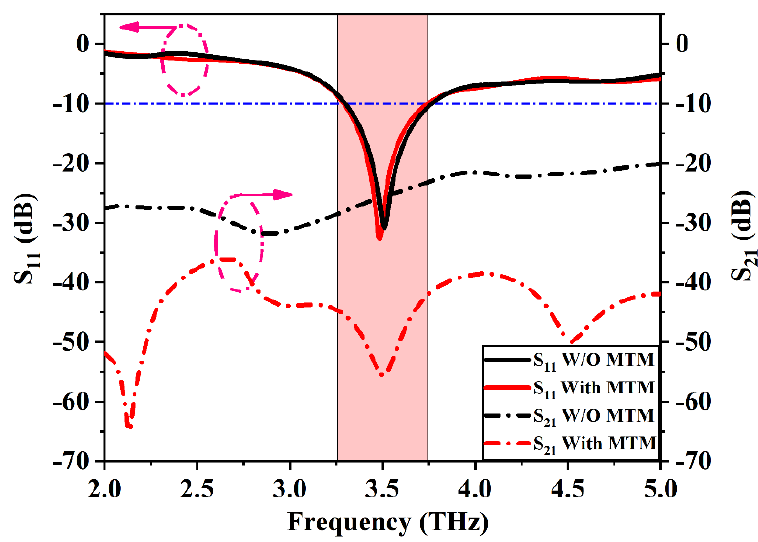
Figure 18. S − Parameters (S 11 and S 21 ) of Ant. C with and without the MTM unit cell . Figure 18. S–Parameters (S 11 and S 21 ) of Ant. C with and without the MTM unit